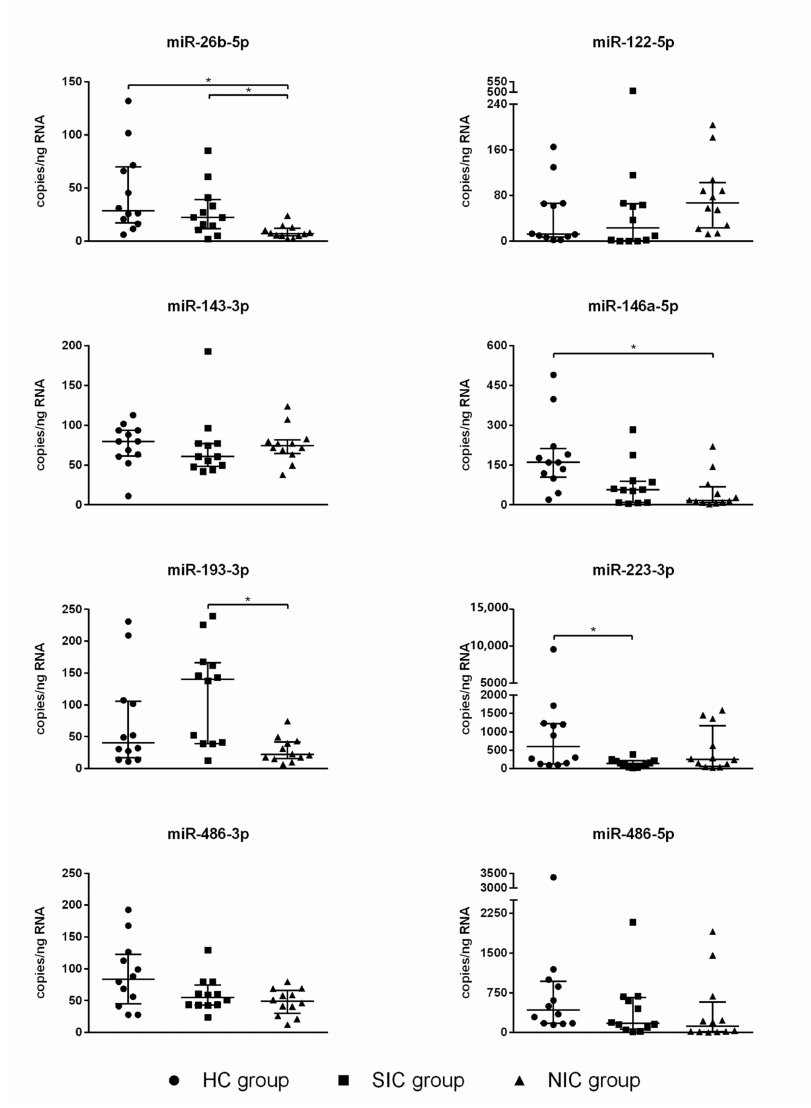
Figure 5. Serum copy counts of the miRNAs miR-26b-5p, miR-122-5p, miR-143-3p, miR-146a-5p, miR-193-3p, miR-223-3p, miR-486-3p, and miR-486-5p were determined by means of the Droplet Digital PCR technology. The blood sample was taken immediately after admission to the intensive care unit (ICU). Data are presented as median ± IQR ( n = 12, n = 2); the asterisk denotes a significant ( p < 0.05) group di ff